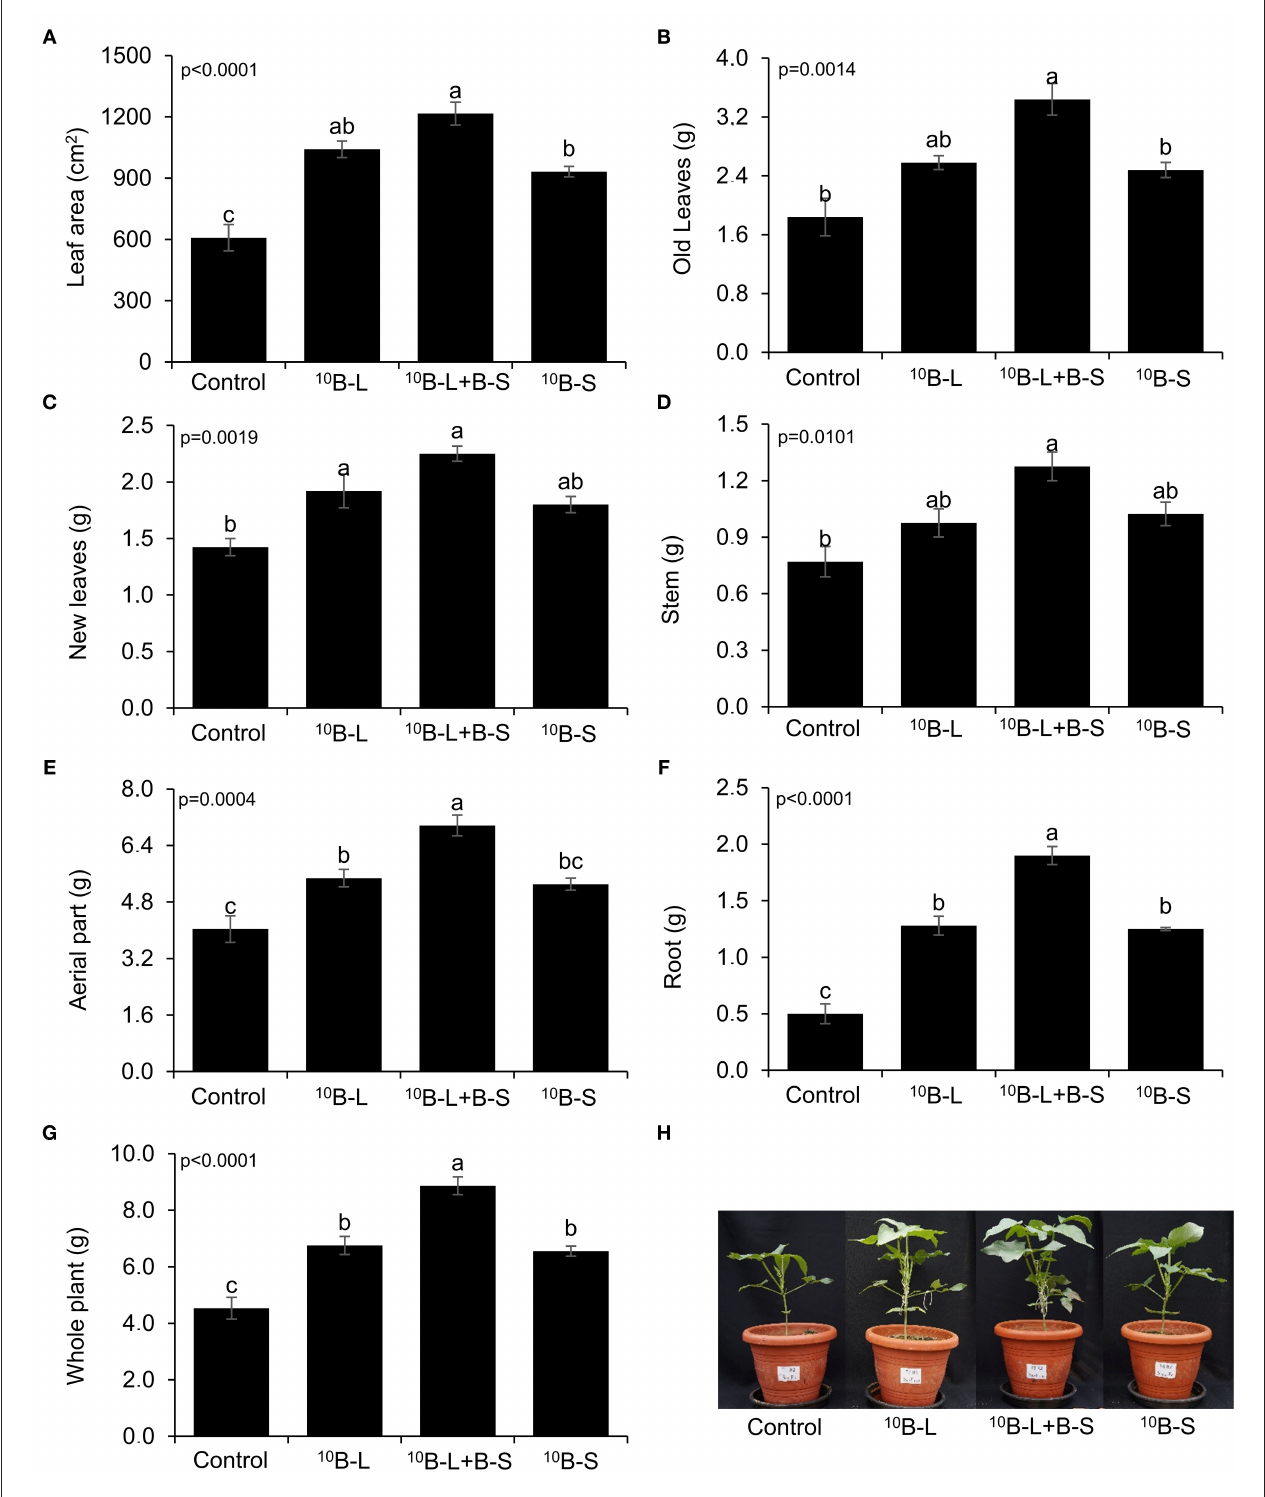
FIGURE 3 | Leaf area (A) , old leaves (B) , new leaves emerged after foliar spraying (C) , stems (D) , aerial part (E) , roots (F) , and whole plant (G) , depending on the application of B in cowpea plants, and photographs of the plants showing the effects of treatments (H) . Control, without boron fertilization on the substrate (growth media) and leaves; 10 B-L, without B on the substrate (growth media) and with 10 B via leaf; 10 B-L + B-S, fertilization with B on the substrate (growth media) and 10 B via the leaf/the foliage; 10 B-S, fertilization with 10 B on the substrate (growth media) and without fertilization with B via the leaf/the foliage. Bars represent the standard errors of means. Lowercase letters indicate significant differences among treatments, according to Tukey’s test at a 5% probability level. Values are presented as mean ± SE.